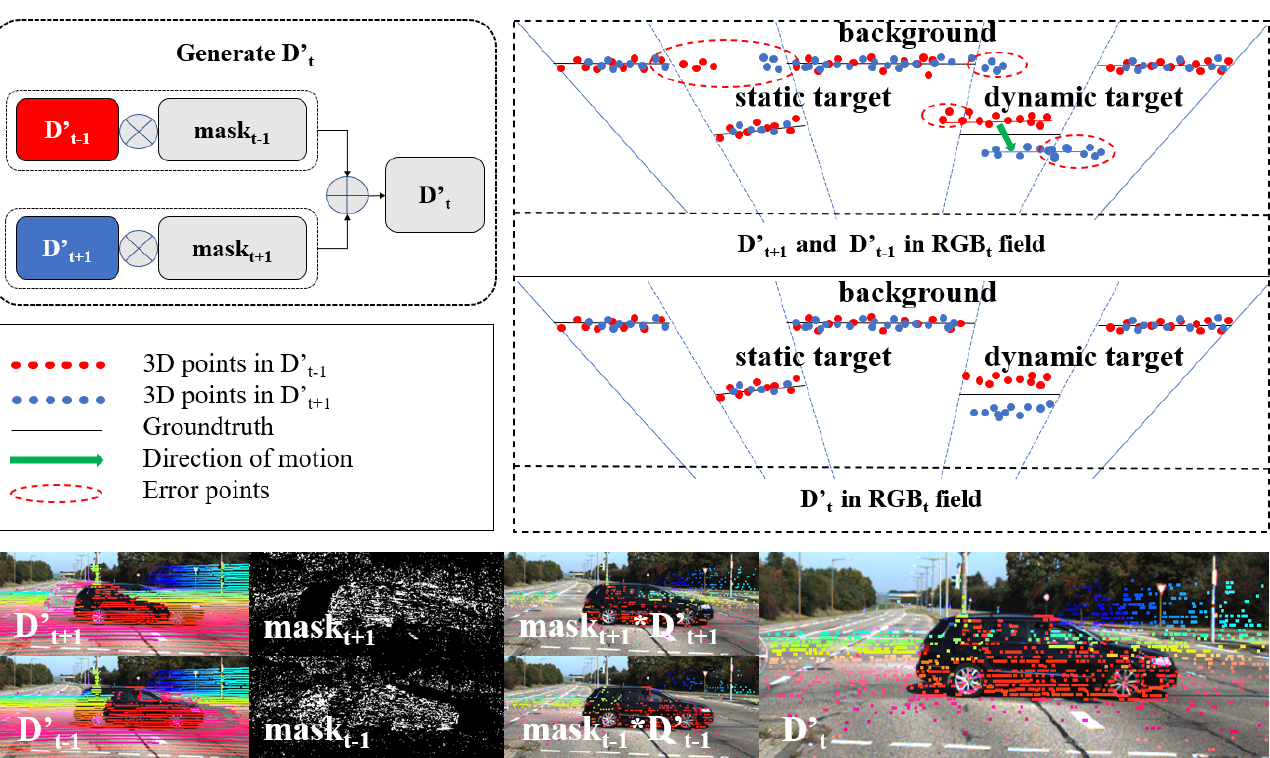
D (cid:48) (visual process in the bottom). D (cid:48) t t + i